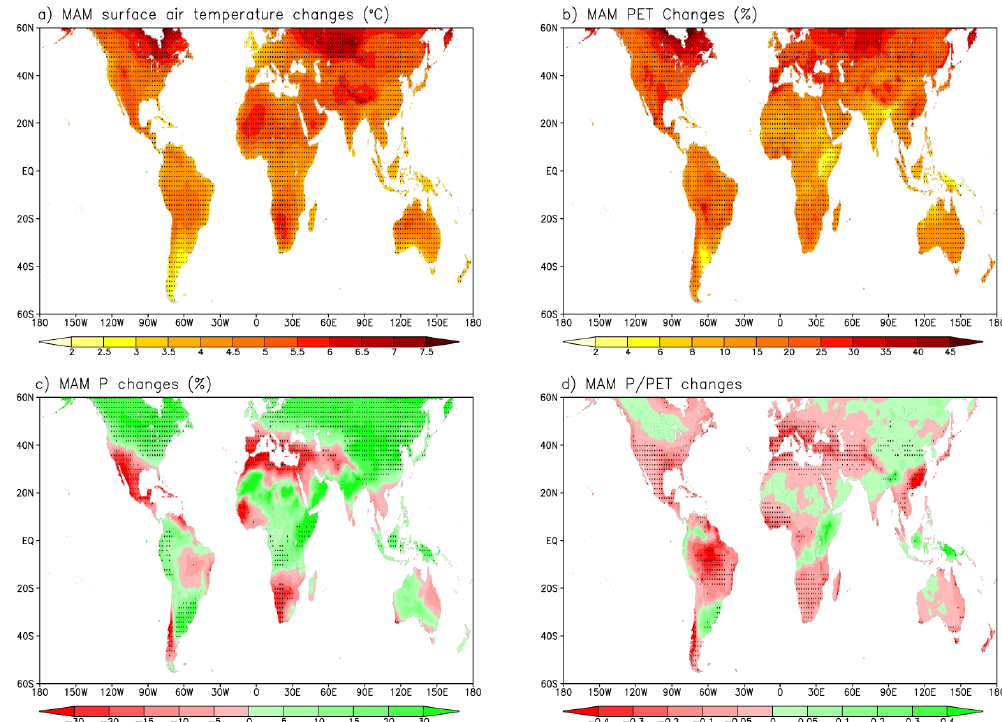
Fig. 12. Same as Fig. 7 but for the season of